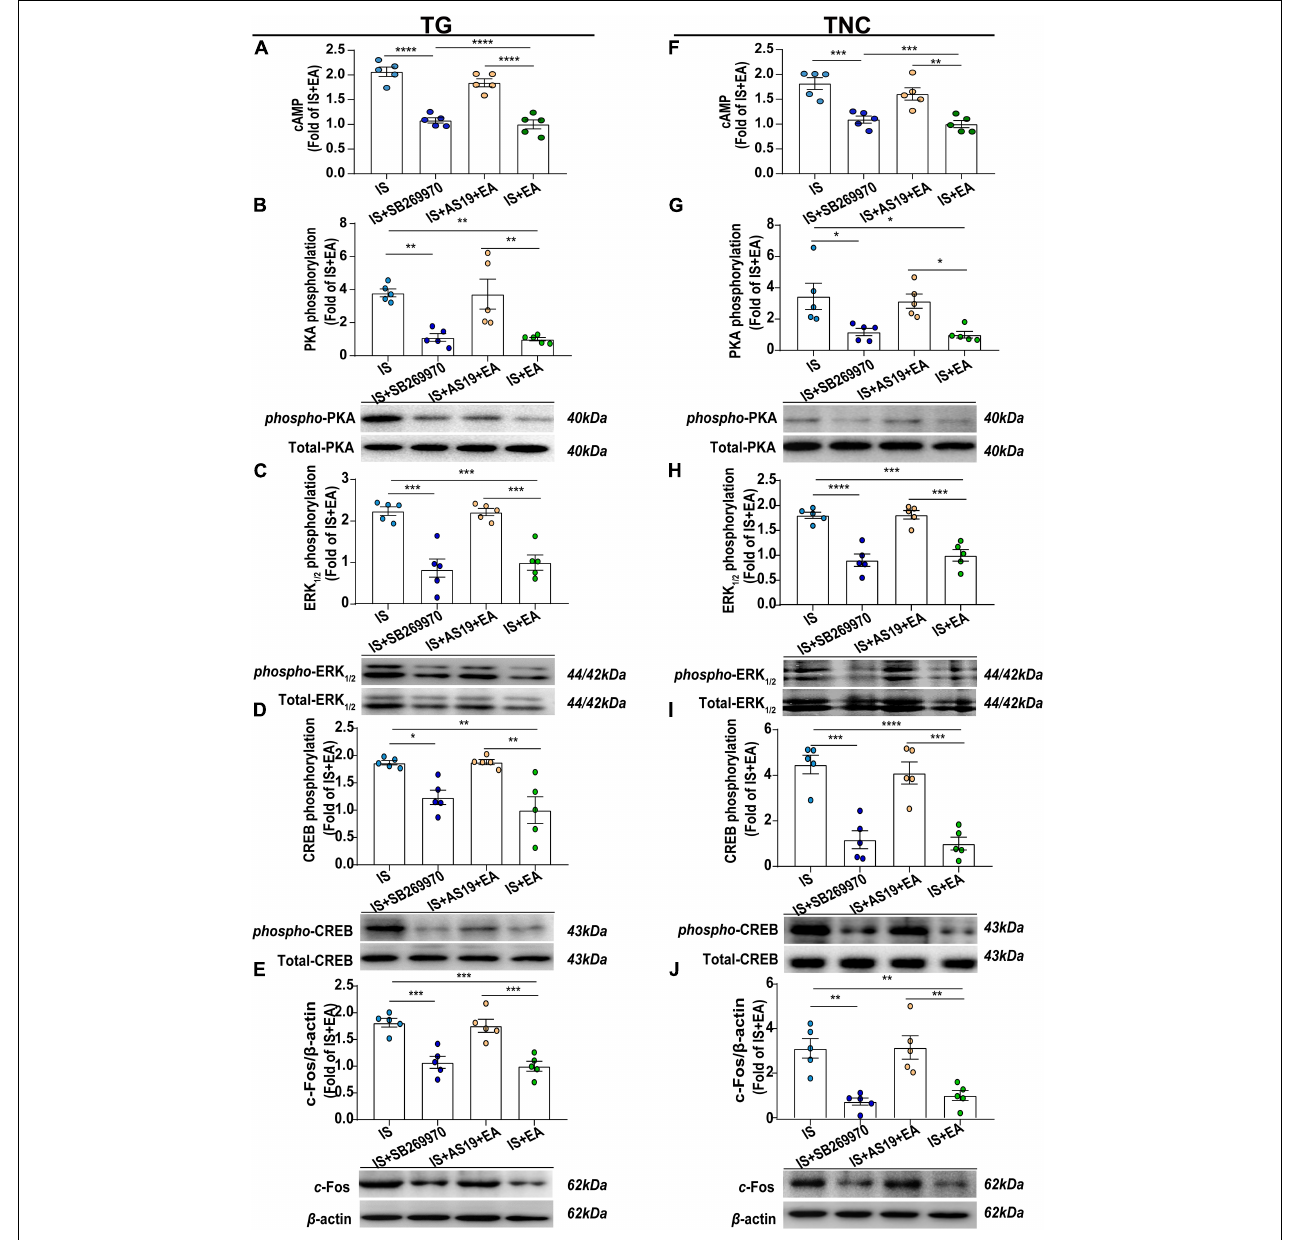
FIGURE 9 | Roles of 5-HT 7 R-associated PKA, ERK 1 / 2 phosphorylation signaling pathway in EA’s antihyperalgesic effects. Results were averages of cAMP production as evaluated by ELISA ( n = 5) (A,F) . Representative Western blots of phosphorylated and total PKA (B,G) , ERK 1 / 2 (C,H) , and CREB (D,I) , as well as c-Fos (E,J) . The densitometric analysis of phosphorylated and c-Fos protein levels detected from the TG and TNC of IS, IS + SB269970, IS + AS19 + EA, and IS + EA. One-way ANOVA followed by post hoc Tukey test. Group values are indicated by mean ± SEM. * P < 0.05, ** P < 0.01, *** P < 0.001, **** P < 0.001. 5-HT 7 R, 5-hydroxytryptamine (5-HT) 7 receptor; PKA, protein kinase A; ERK 1 / 2 , extracellular signal-regulated kinase 1 / 2 ; CREB, cAMP-responsive element-binding protein; TG, trigeminal ganglion; TNC, trigeminal nucleus caudalis; EA, electroacupuncture; IS, inflammatory soup; AS19, 5-HT7R agonist; SB269970, 5-HT7R